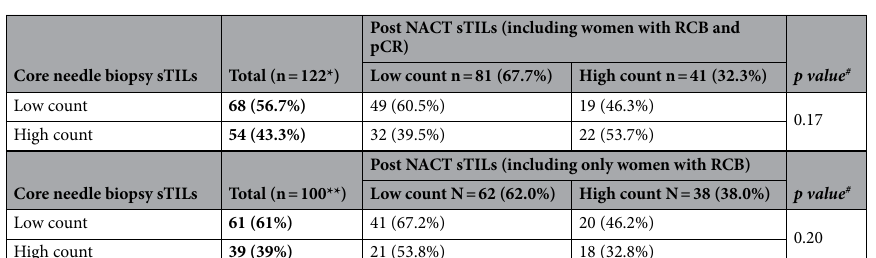
Table 4. Correlation of sTIL counts in paired cases, pre (core needle biopsy) and post neoadjuvant chemotherapy. Values in bold indicate data of statistical significance. *Five women with RCB had no tissue post-NACT for sTILs evaluation. **Additional twenty-two women were excluded because of pCR and three with RCBI. sTILs: stromal tumor infiltrating lymphocytes; NACT: neoadjuvant chemotherapy. # p value calculation using McNemar’s paired